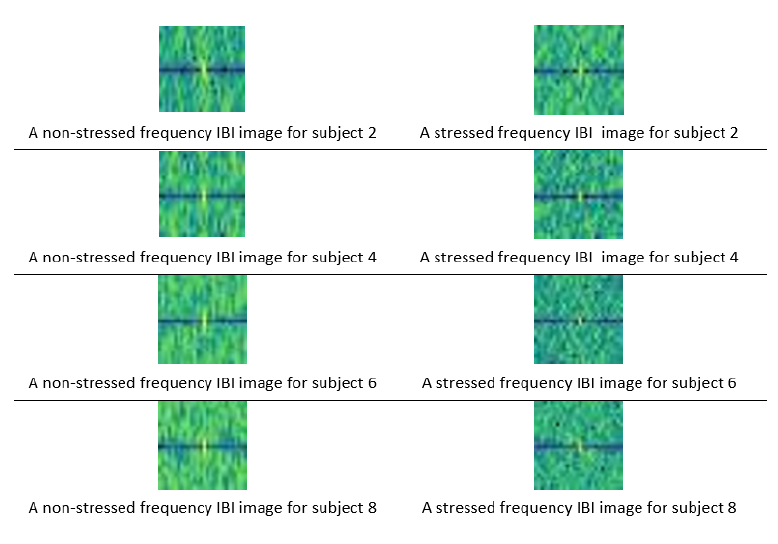
Figure 5. Stressed and non-stressed frequency domain images for several